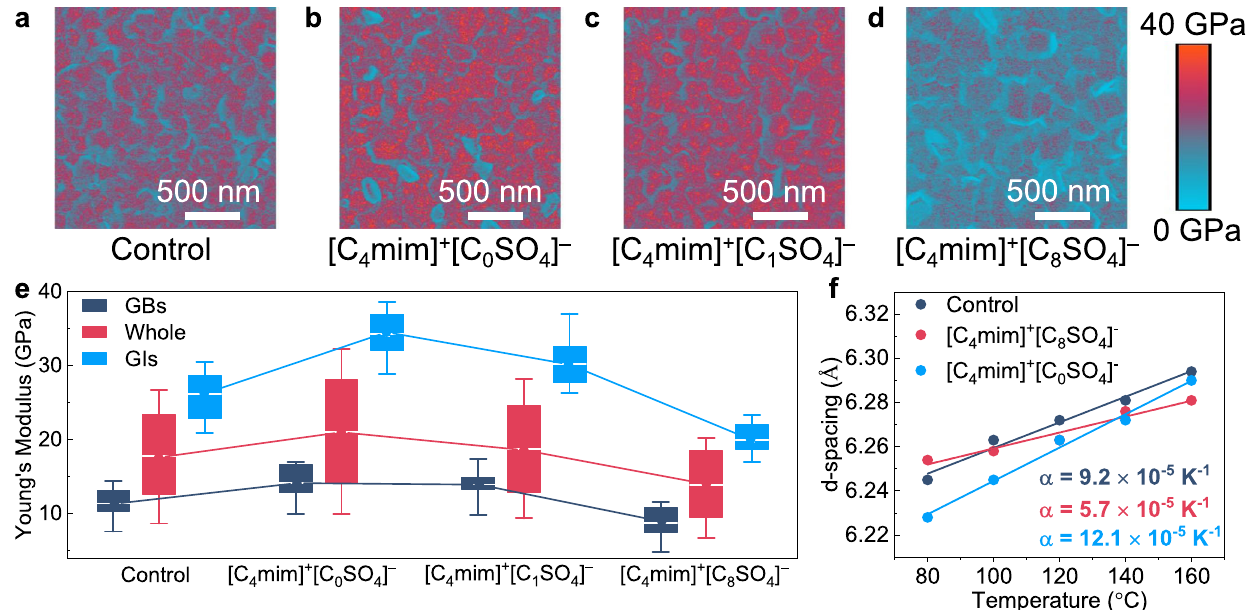
Fig. 1 | Reduction of residue stress via LASs. a – d PFQNM-AFM mapping of per- ovskite thin fi lms. Young ’ s Modulus maps of perovskite fi lm without (referred as control sample) ( a ) additives, [C 4 mim] + [C 0 SO 4 ] − ( b ), [C 4 mim] + [C 1 SO 4 ] − ( c ) and